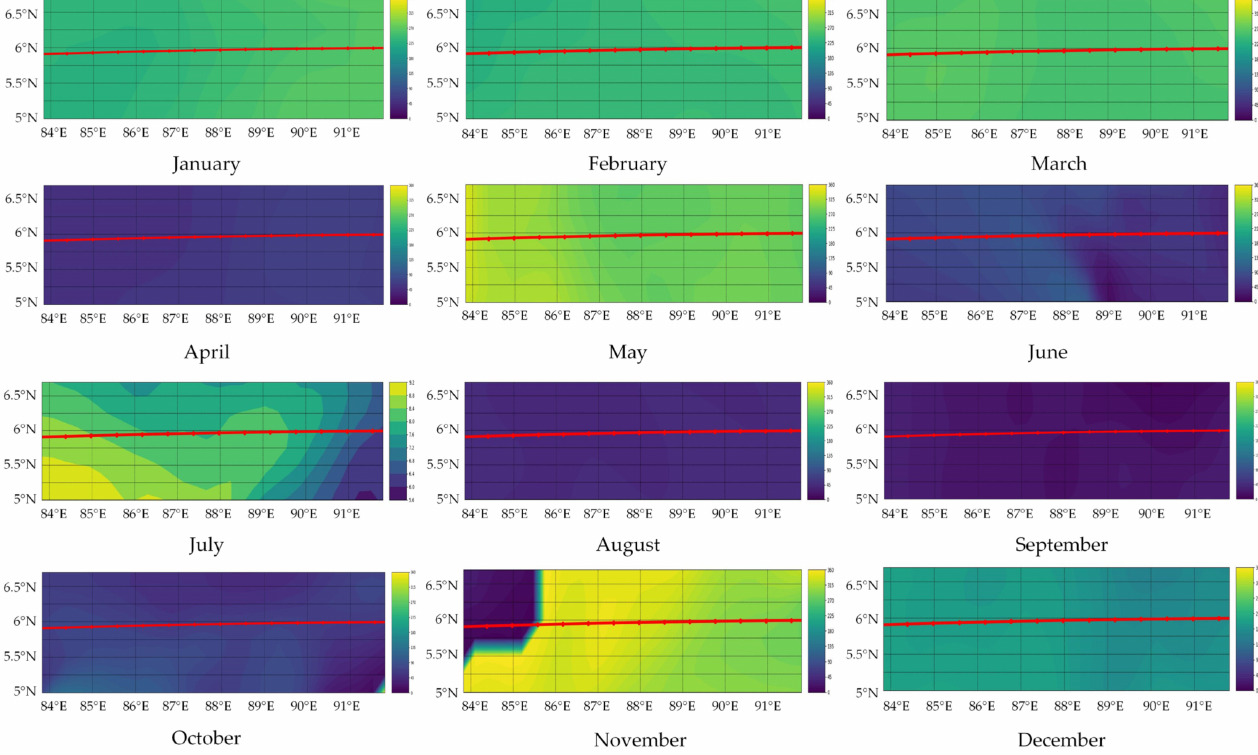
Figure 14. Spatial–temporal distribution characteristics of wind direction angle in Bay of